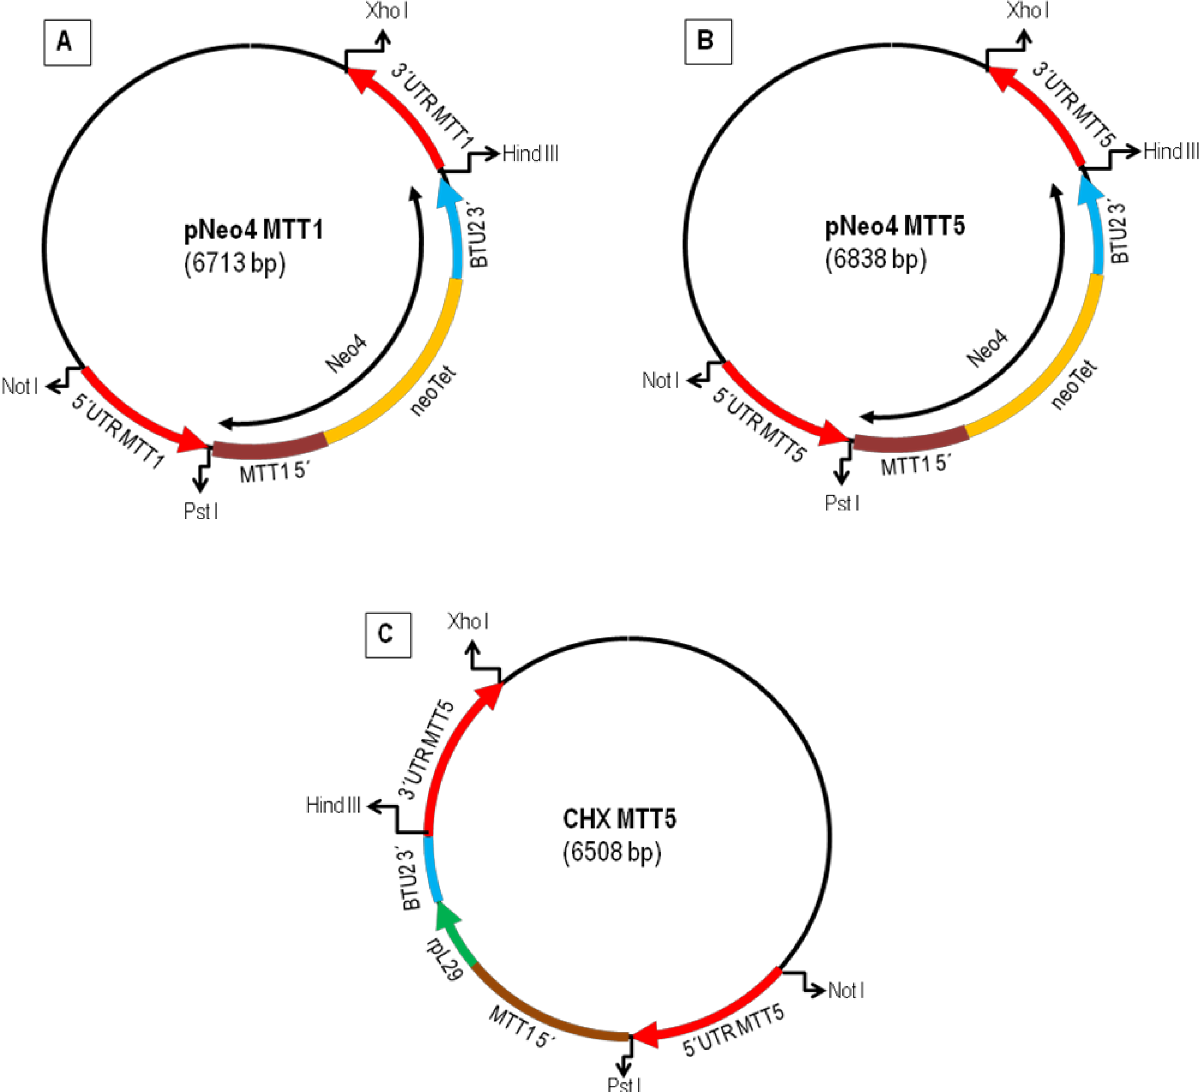
Fig 1. Schematic representation of the plasmid constructs used to obtain knockout and/or knockdown strains. (A): plasmid construct (pNeo4MTT1)used for MTT1KO strain. (B): plasmidconstruct (pNeo4MTT5) used for MTT5KD. (C): plasmidconstruct (pCHXMTT5) used for obtaining MTT1KO + MTT5KD. neoTet: neomycin/paromomycin resistancegene. rpl29: cycloheximide resistance gene. BTU2 3’: part of the 3’UTR regionof the β -tubulin 2